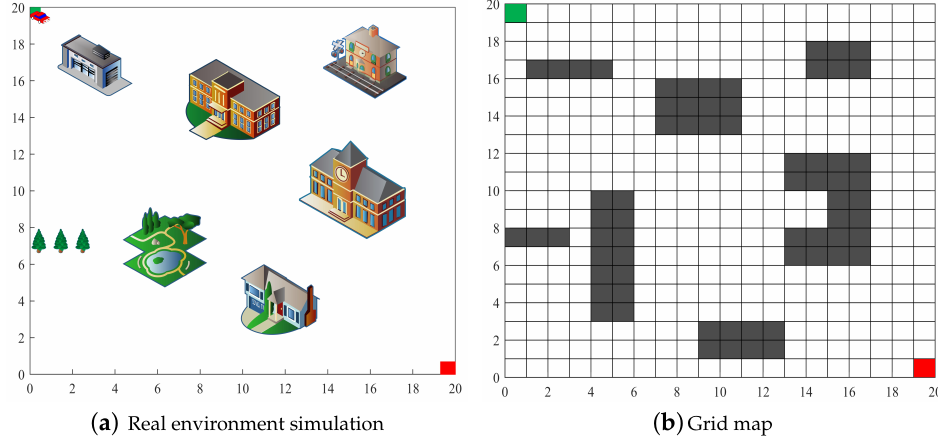
Figure 1. Demonstration of how to convert the actual environment into a grid